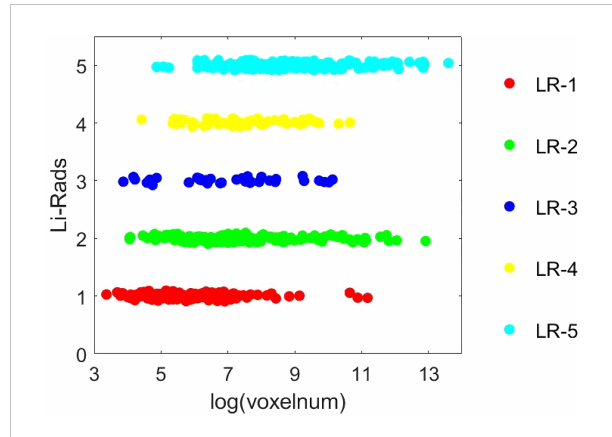
FIGURE 3 The distribution of LI-RADS results.